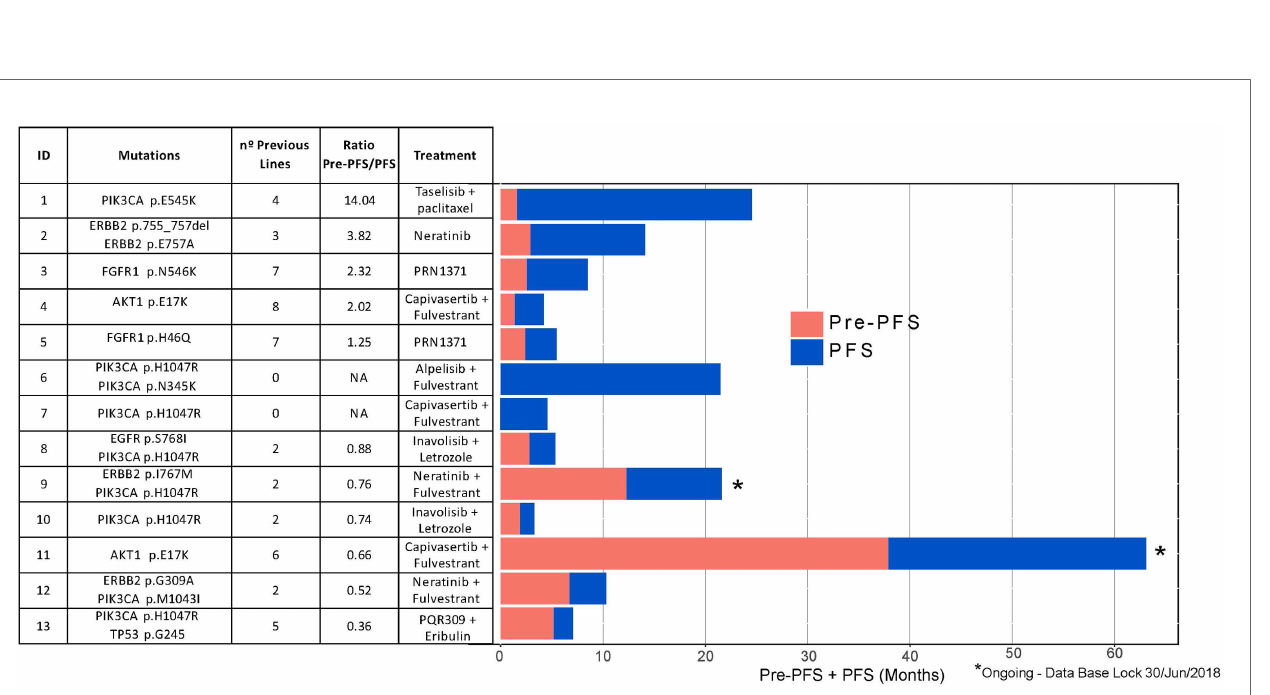
FIGURE 2 | Frequency (percentage) of the genomic alterations in all patients pro fi led according to primary (n = 163) and metastatic tumors (n = 97).